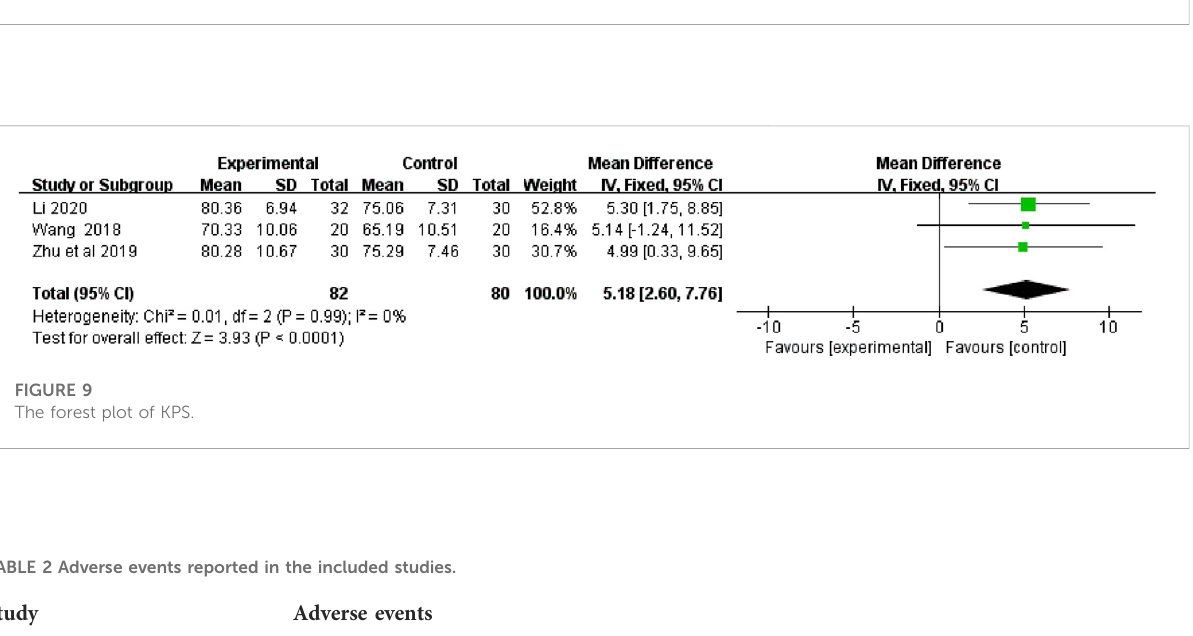
FIGURE 8 The forest plot of QLQ-C30.